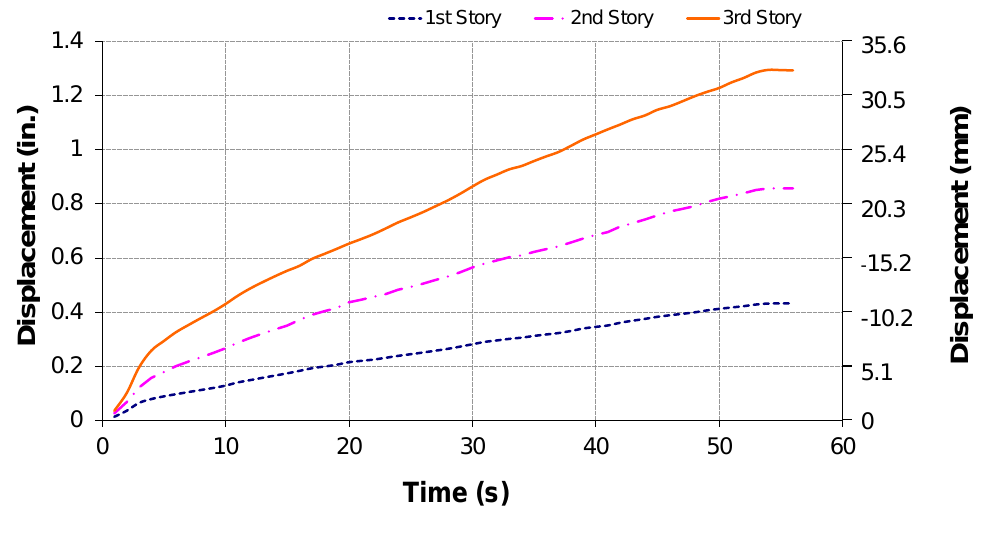
Figure 9. Bare frame cyclic test 2 (BFMT2) displacement